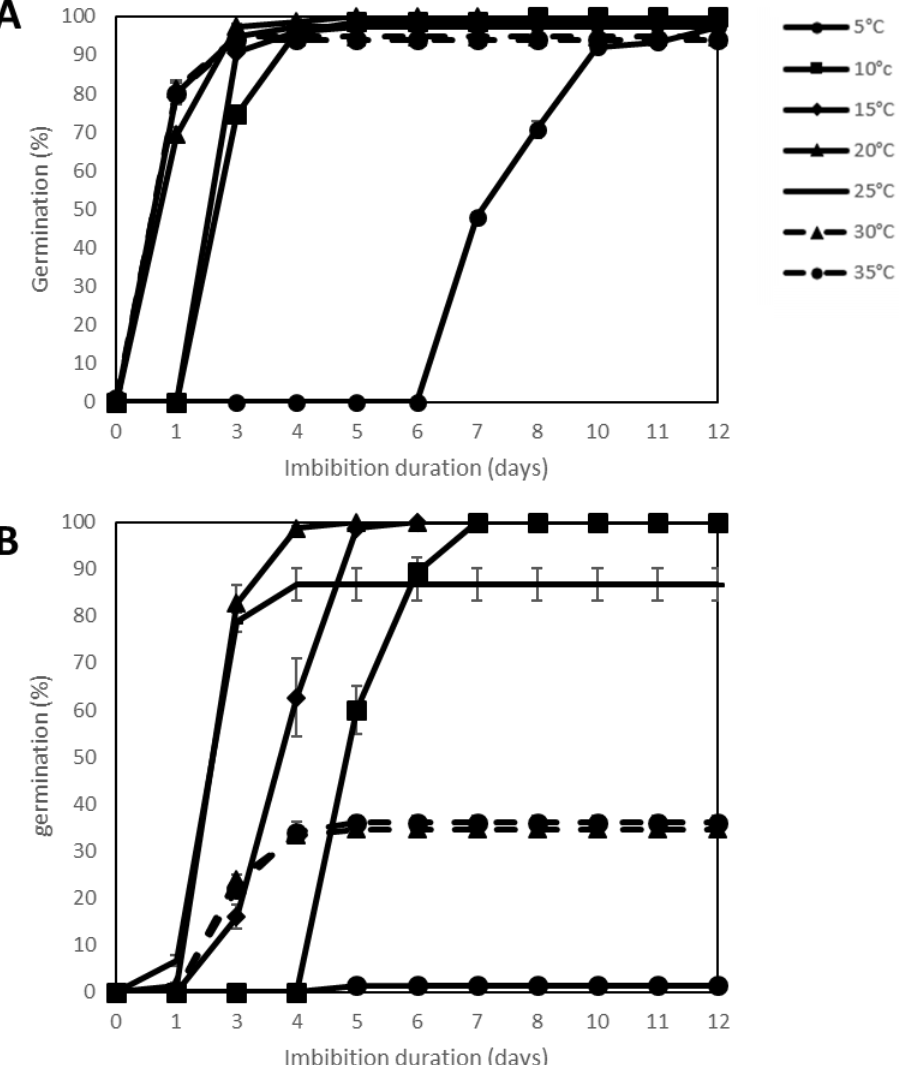
Figure 2. Germination curves of 2 sunflower genotypes, Helianthus annuus sp. SOLQUA-160 ( A ) and SOLQUA-165 ( B ) Temperature stress (5, 10, 15, 25, 30 and 35 °C) was applied during germination in comparison to the control on water at 20 °C.